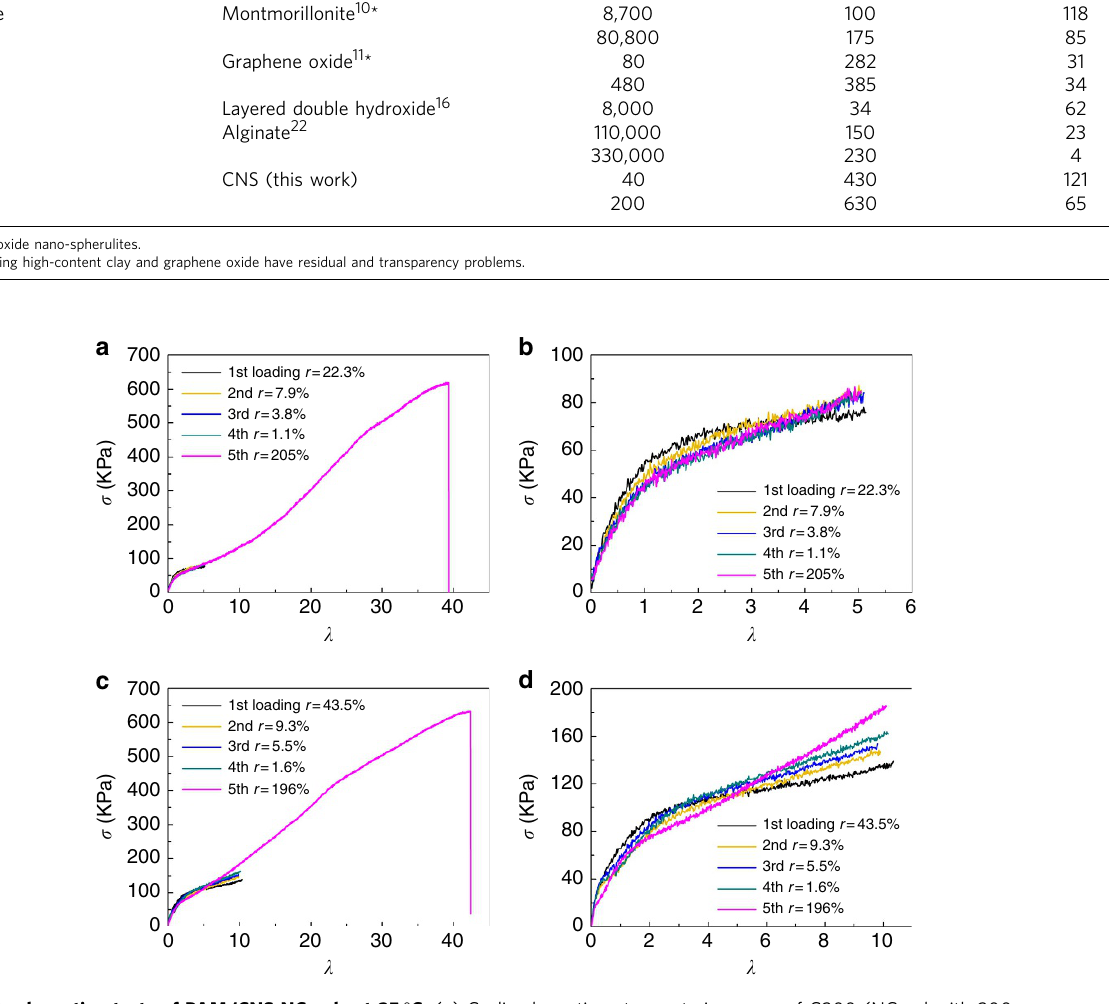
Figure 8 | Cyclic elongation tests of PAM/CNS NC gels at 25 (cid:2) C. ( a ) Cyclic elongation stress–strain curves of C200 (NC gel with 200p.p.m. CNS concentration) elongated for five-fold in four cycles and elongated to rupture at the fifth cycle. ( b ) Enlarged cyclic elongation stress–strain curves of C200 elongated for five-fold in four cycles. ( c ) Cyclic elongation stress–strain curves of C200 elongated for 10-fold in four cycles and elongated to rupture at the fifth cycle. ( d ) Enlarged cyclic elongation stress–strain curves of C200 elongated for 10-fold in four cycles. s represents the stress. l represents the stretch ratio. r represents the ratio of the length change along the direction of load after the load is released with respect to the original length of the